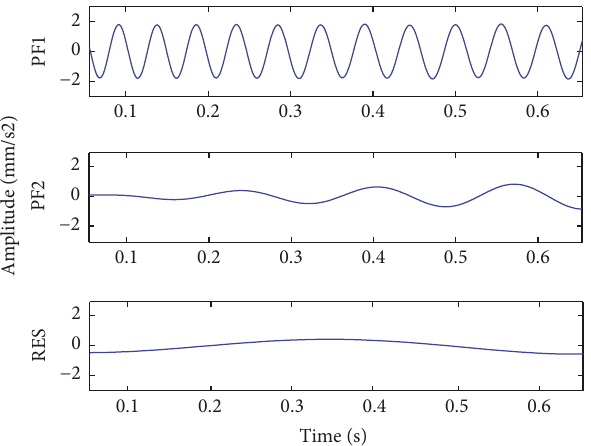
Figure 4: LMD results of the extremal mirror extension method.